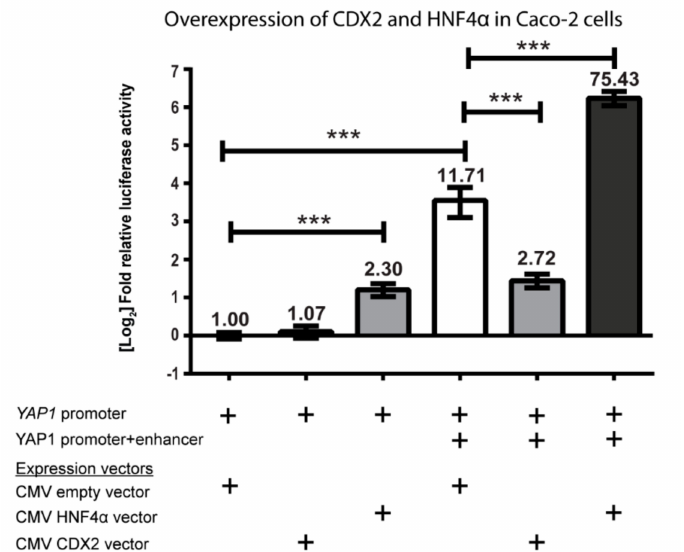
Figure 5. Relative luciferase / β -galactosidase activity from cell lysates of Caco-2 cells transfected with pGL4.10 luciferase reporter constructs containing the YAP1 promoter and / or + 82 kb enhancer. Cytomegalovirus (CMV)-HNF4 α , CMV-CDX2 expression vector or an empty CMV vector were co-transfected with the pGL4.10 plasmids for the overexpression of HNF4 α and CDX2. The relative luciferase / β -galactosidase activity was normalized to the pGL4.10- YAP1 promoter construct. Bars are mean values plotted on a log2 scaled y-axis, with error bars showing 95% CI. + indicates the presence of a YAP1 promotor or enhancer sequence in the luciferase reporter sequence, or the addition of a CMV-based expression vector to the transfection. Data are statistically significant using two-tailed unpaired student’s T -test with p -values under 0.001 (***), n =